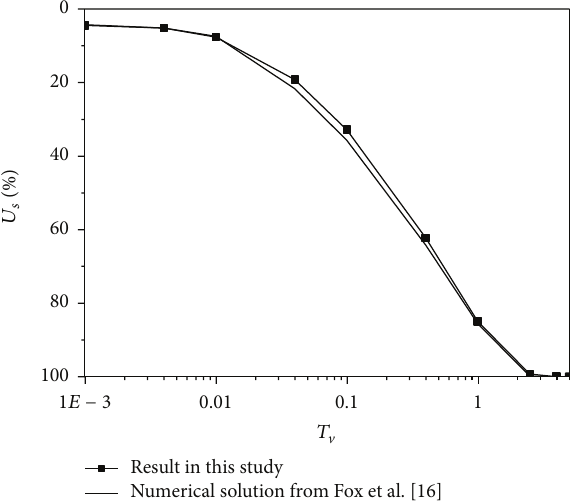
Figure 6: Degree of consolidation for a single layer